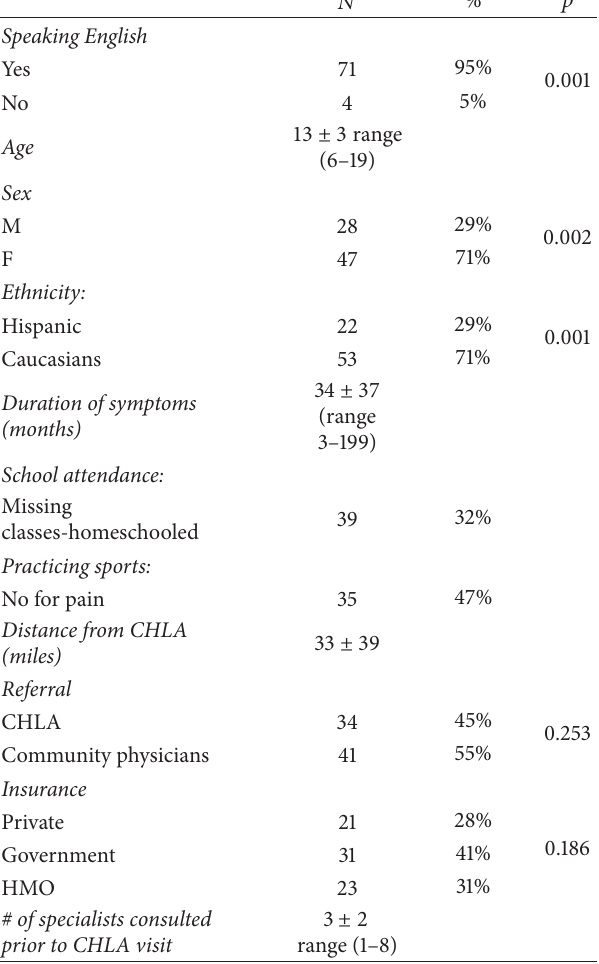
Table 1: Demographic data of the study population (CHLA: Children’s Hospital Los Angeles; HMO: Health Maintenance Orga- nization).